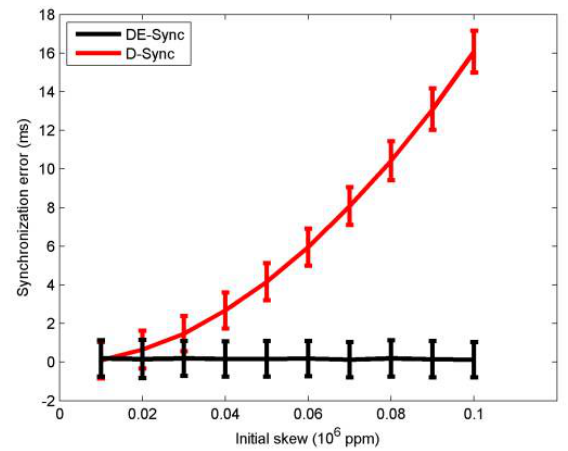
Figure 3. Performance with initial skew.